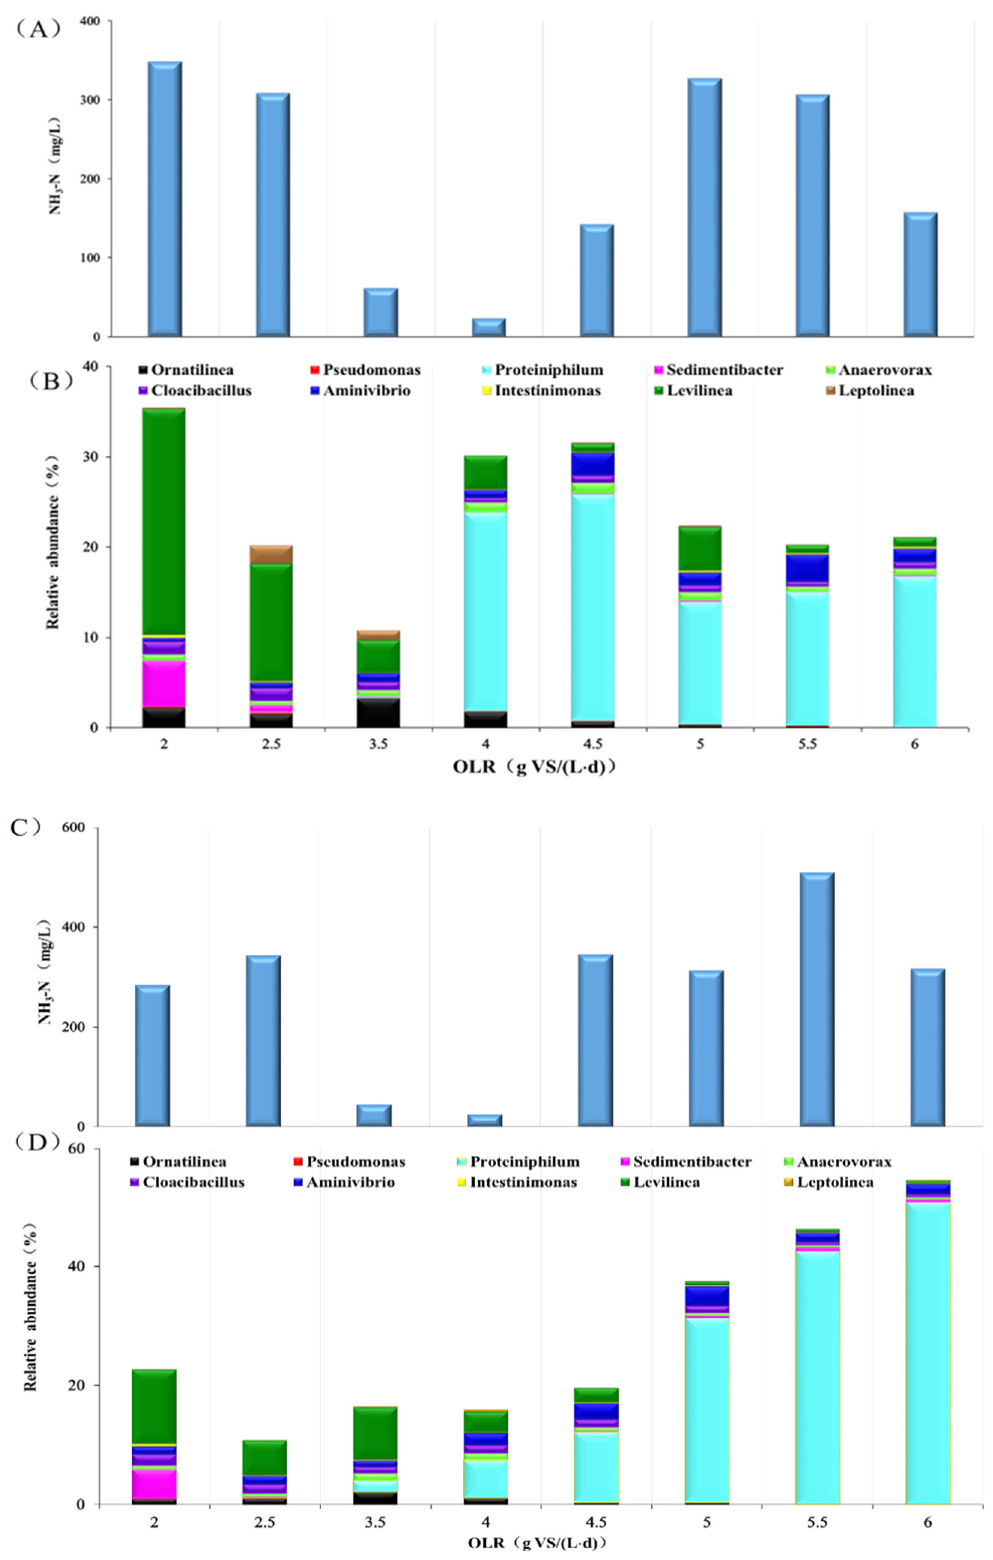
Figure 2. The NH3-N concentration and the bacteria in genus level for GM11 and GM31. ( A ) The NH3-N concentration of GM11. ( B ) The bacteria contributed to the nitrogen conversion of GM11. ( C ) The NH3-N concentration of GM31. ( D ) The bacteria contributed to the nitrogen conversion of GM31.